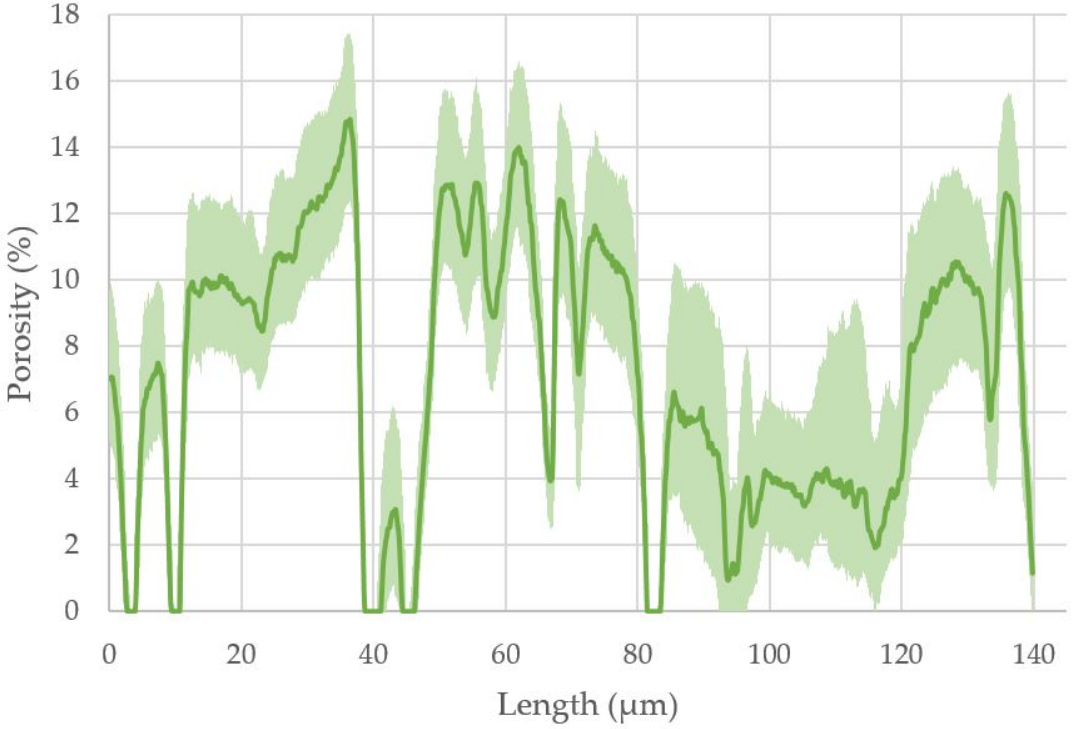
Figure 5. Porosity content along fibre “a” measured for the median threshold value and displaying the upper and lower limit corresponding to the limits of the chosen threshold range.